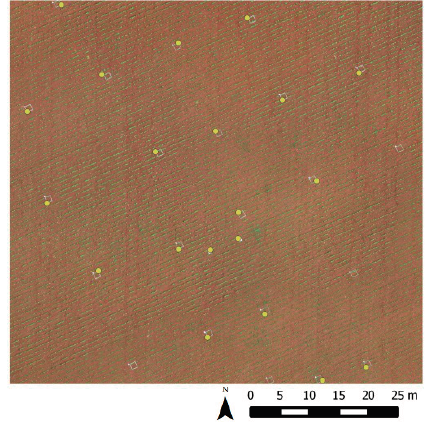
Figure 1. Representation of the 20 selected points for the American Society of Photogrammetry and Remote Sensing (ASPRS) test for Field